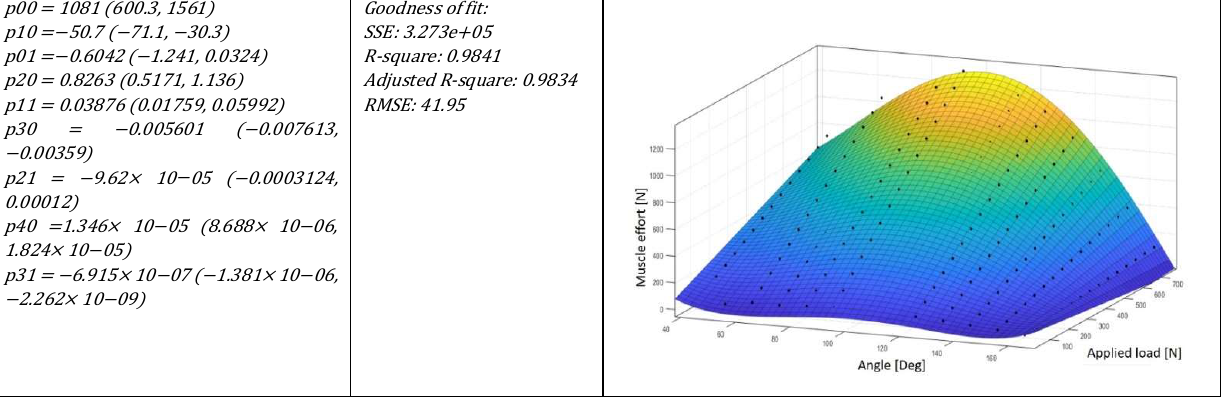
Figure 17. General formulation of lateral triceps efforts based on wrist load on the wrist (W) and elbow angle ( α ) and surface reconstruction of the proposed polynomial.